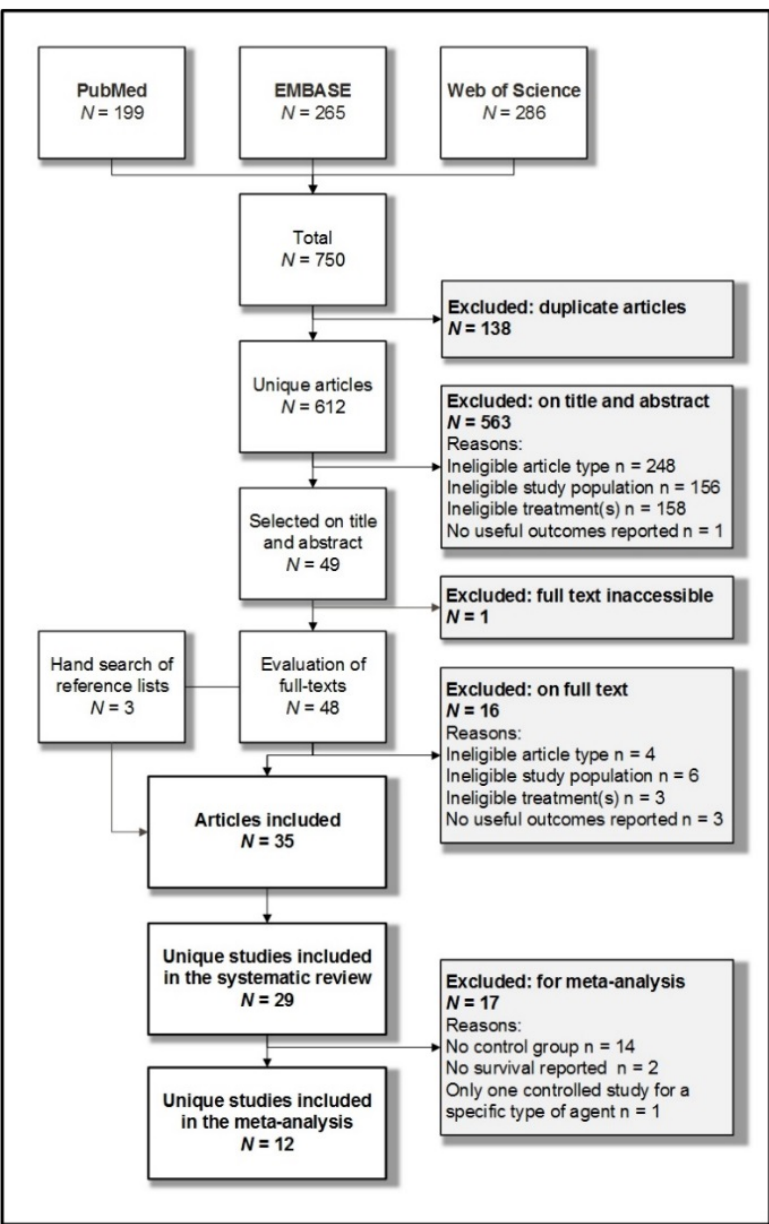
Figure 1. Systematic search and article selection process.